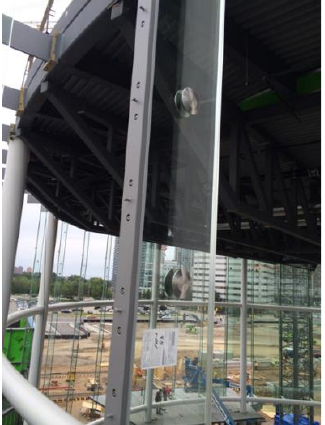
Fig. 15 Construction photo of fin splice. Fig. 16 Construction photo of hanging